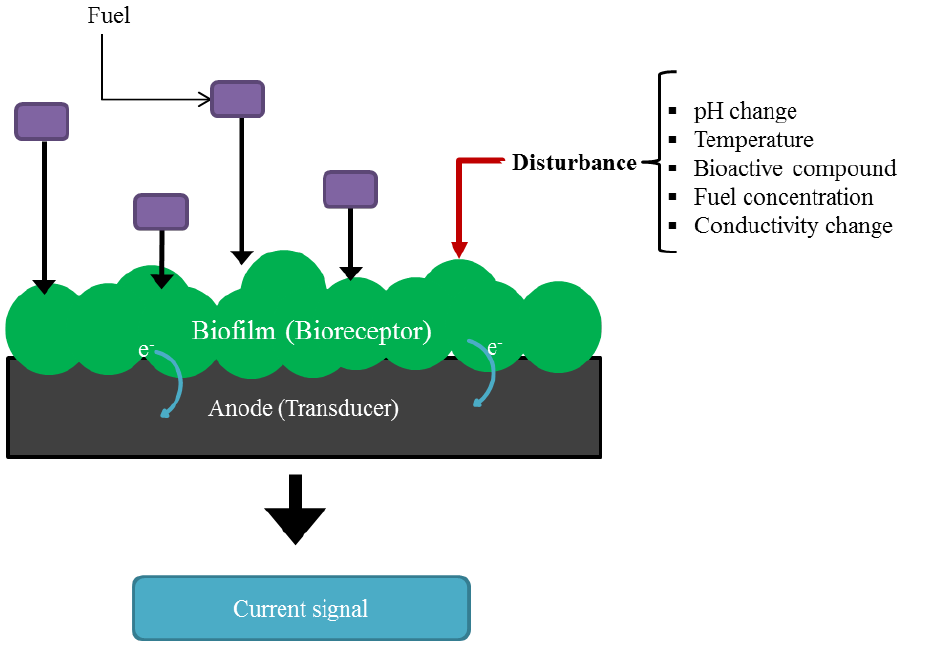
Figure 3. Basic principle of an MFC as a